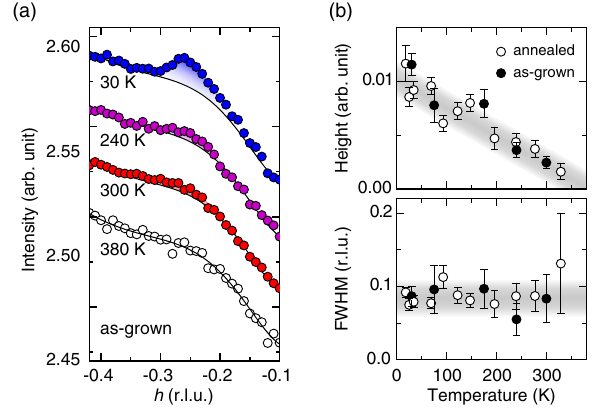
FIG. 2. Temperature dependence of the reflection at q ∼ 1 = 4 . (a) Temperature-dependent h scans in the as-grown NCCO ( x ¼ 0 . 14 ), measured at the Cu L 3 edge. The shaded areas denote the portion of the peak above the background (black line), which was taken at T ¼ 380 K. (b) Plots of peak height (upper panel) and the full width half maximum (FWHM) (lower panel) of the peaks at h ∼ − 0 . 26 as a function of temperature. The open and filled circles are from the annealed and as-grown NCCO, respectively. The width is about 0.085 r.l.u. over the entire temperature range. The grey shadow is a guide to the eye, and the error bars denote 1 standard deviation (s.d.) as obtained from the peak